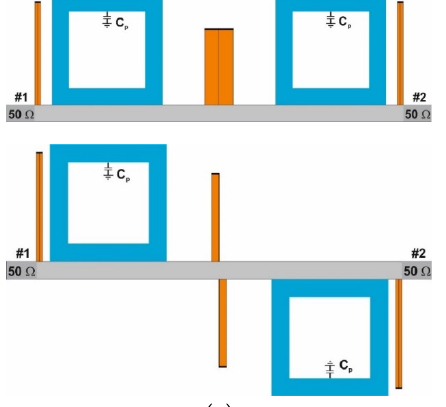
stubs. The two-band filters having the first/second passband with 2nd/4th order are called TBFSLR#1 and TBFSLR#2. TBFSLR#1 has a flat group delay and a very compact size. While TBFSLR#2 is slightly larger than TBFSLR#1, it provides higher selectivity. The layouts of TBFSLR#1 and TBFSLR#2 are given in Figure 13a.